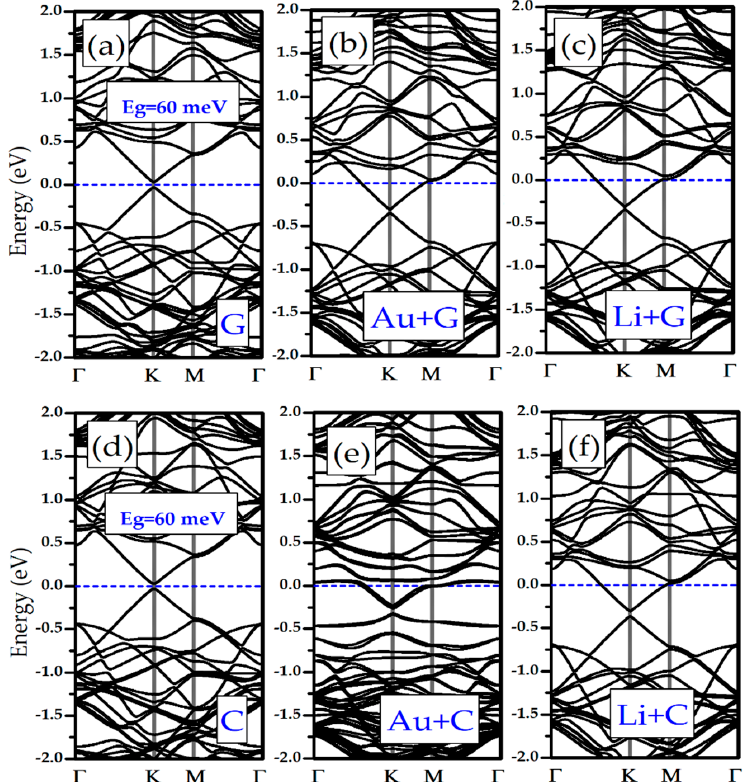
Figure 6. Electronic band structure of: ( a ) Germanene/G, ( b ) Au + Germanene/G, ( c ) Li + Germanene/G, ( d ) Germanene/C, ( e ) Au + Germanene/C, and ( f ) Li + Germanene/C.